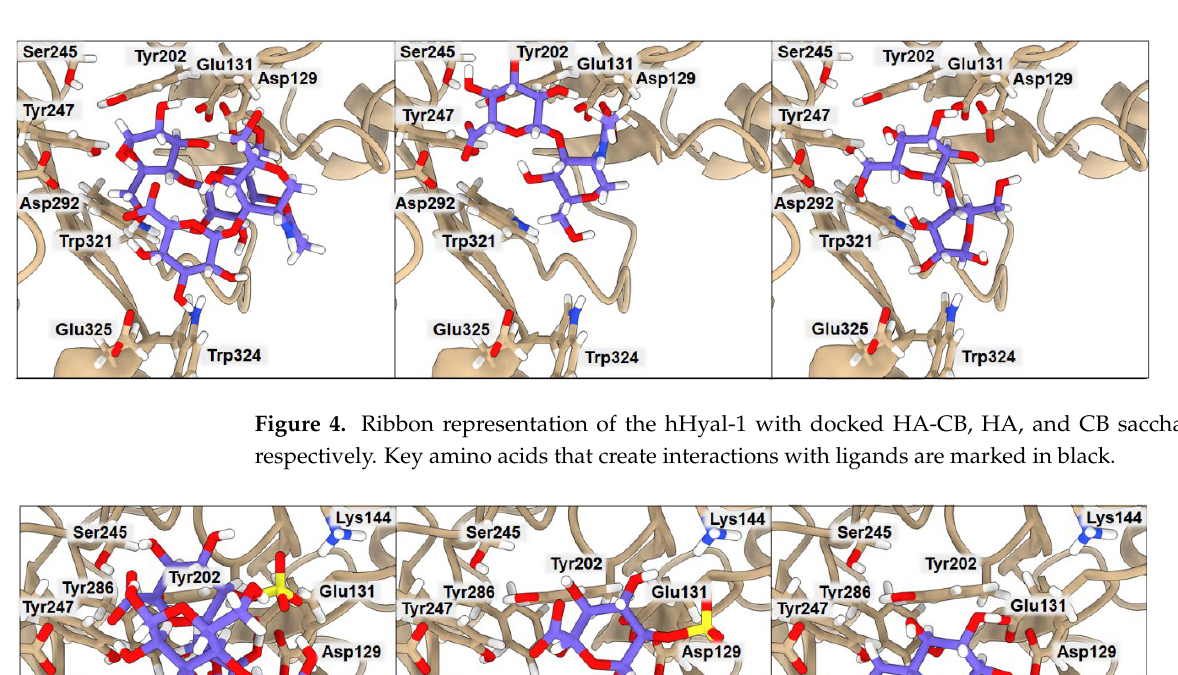
Figure 3. Ribbon representation of the hHyal-1 with docked HA/CHI, HA, and CHI saccharides, from left to right, respectively. Key amino acids that create interactions with ligands are marked in black.